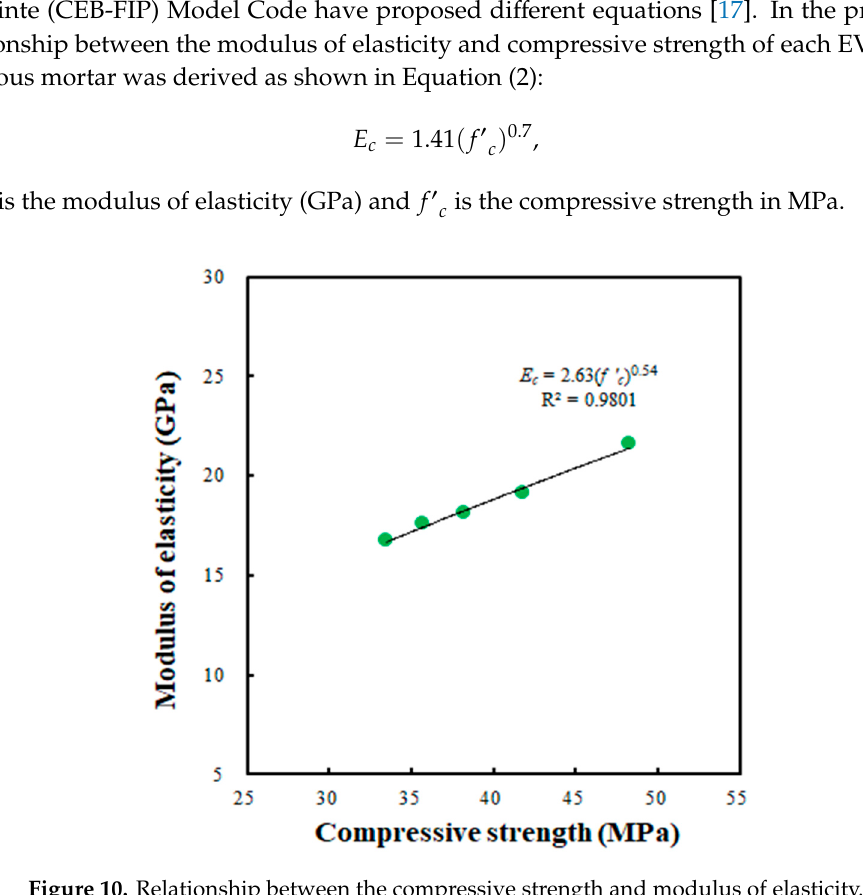
Figure 10. Relationship between the compressive strength and modulus of elasticity.